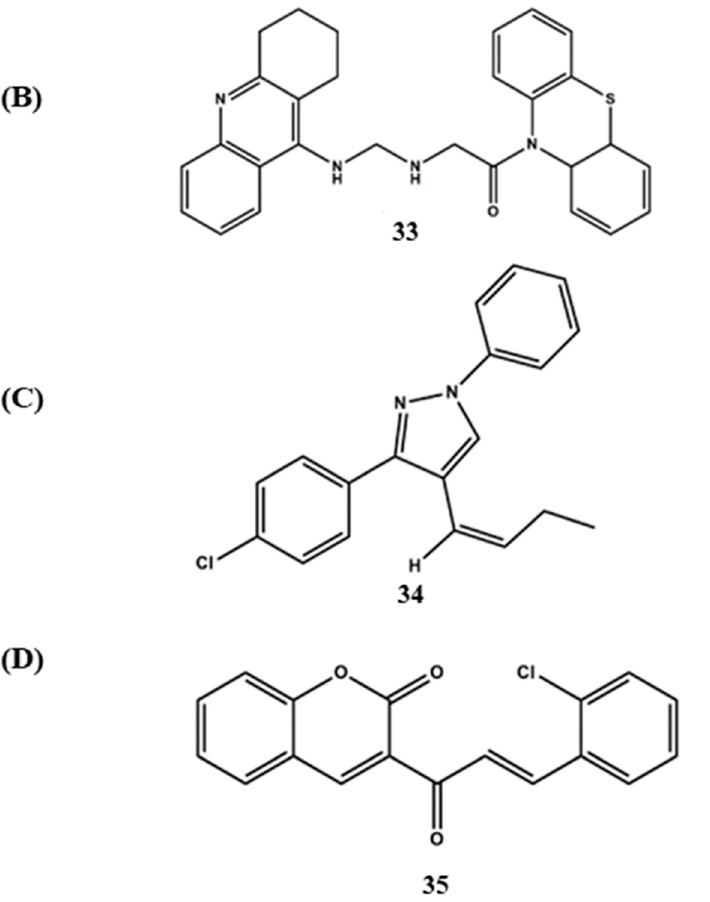
Figure 13. ( A − D ) MTDLs are designed using computational approaches. Figure 13. ( A – D ) MTDLs are designed using computational